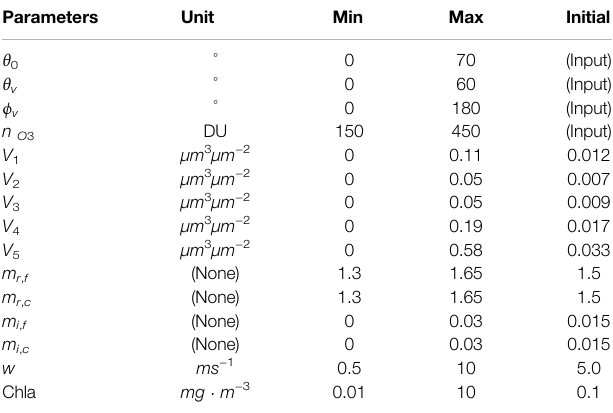
TABLE 4 | Parameters used to represent the radiative transfer of the atmosphere and ocean system. θ 0 and θ v are the solar and viewing zenith angles. ϕ v is the relative viewing azimuth angle. V i denote the volume densities for the fi ve aerosol submodes. m r and m i are the real and imaginary parts of the refractive index. Subscripts f and c refer to fi ne and coarse mode.